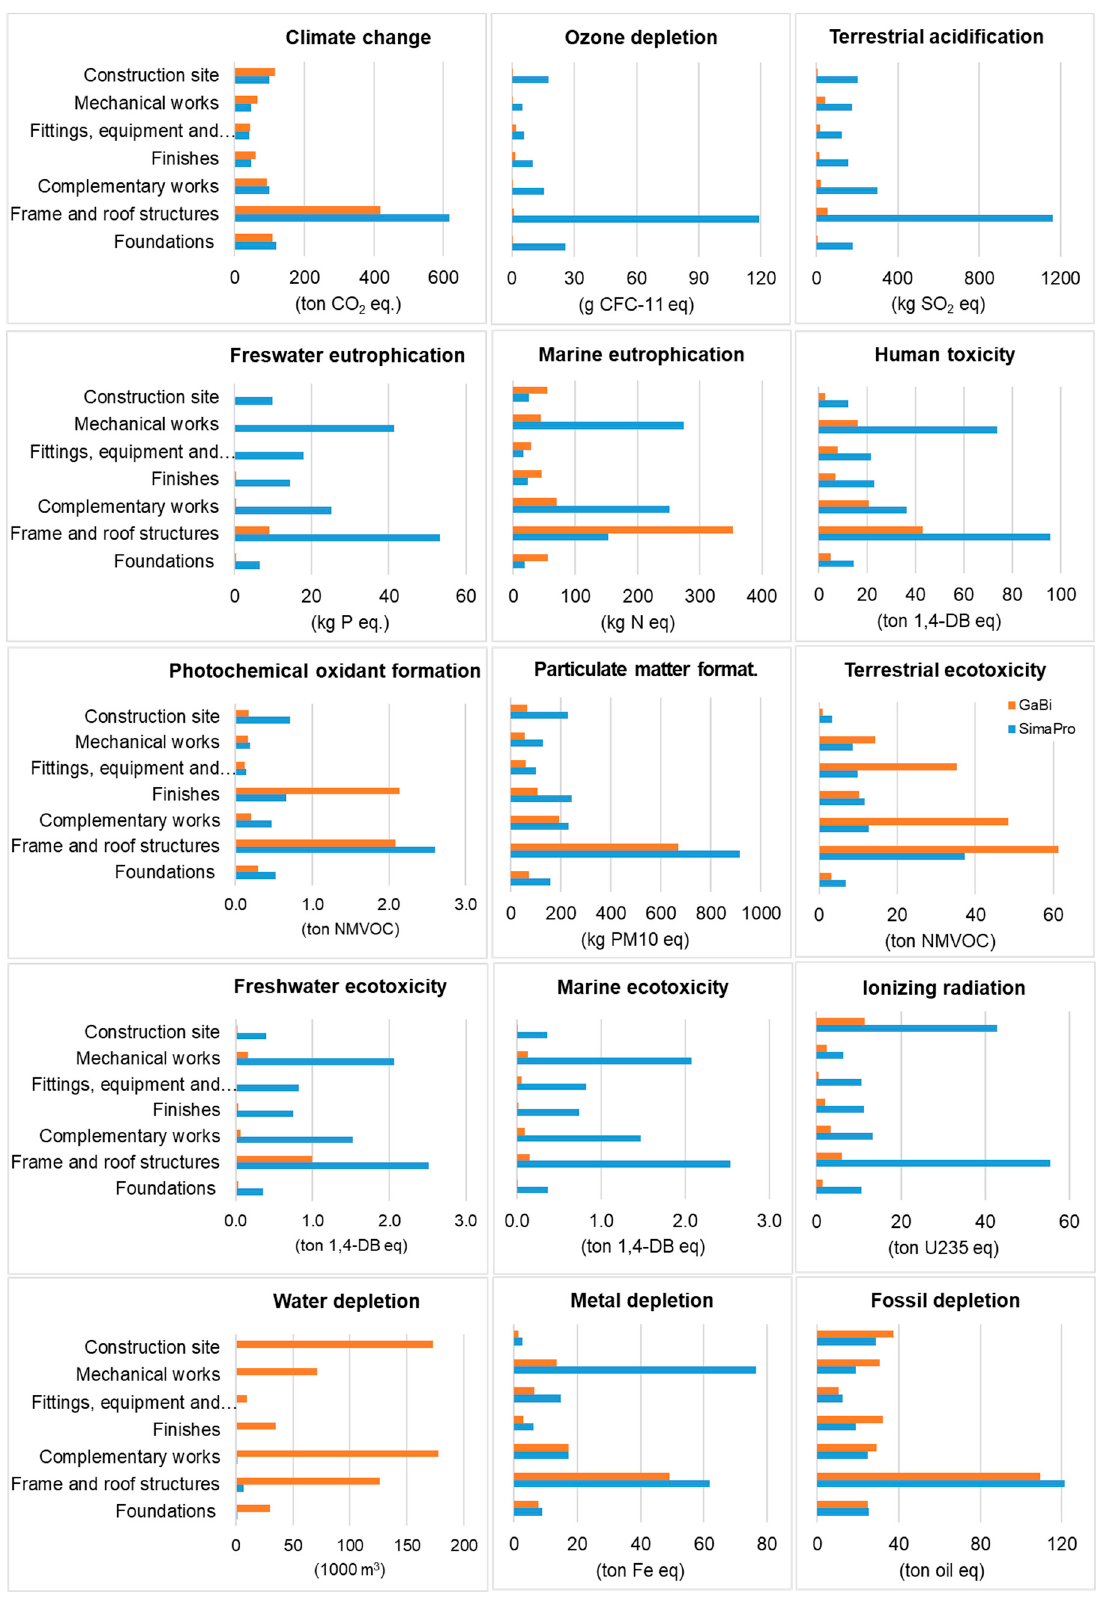
Figure 2. Breakdowns of 15 environmental impacts of Pyry by building system.